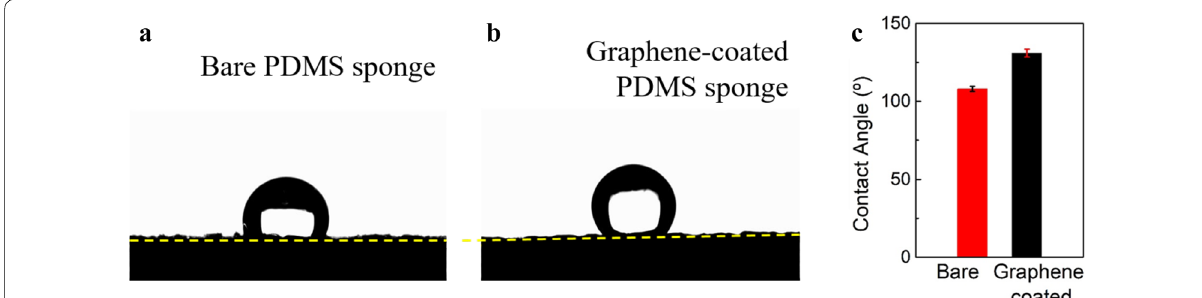
Fig. 3 Static water contact measurements performed on a bare and b graphene-coated PDMS sponge. c The water contact angle was 108 and 131 2.5° on the surface of bare and graphene-coated PDMS sponge, respectively. The water contact angle was increased by the hydrophobic ± property of the PDMS and the enhanced roughened surface due to the porous structure and